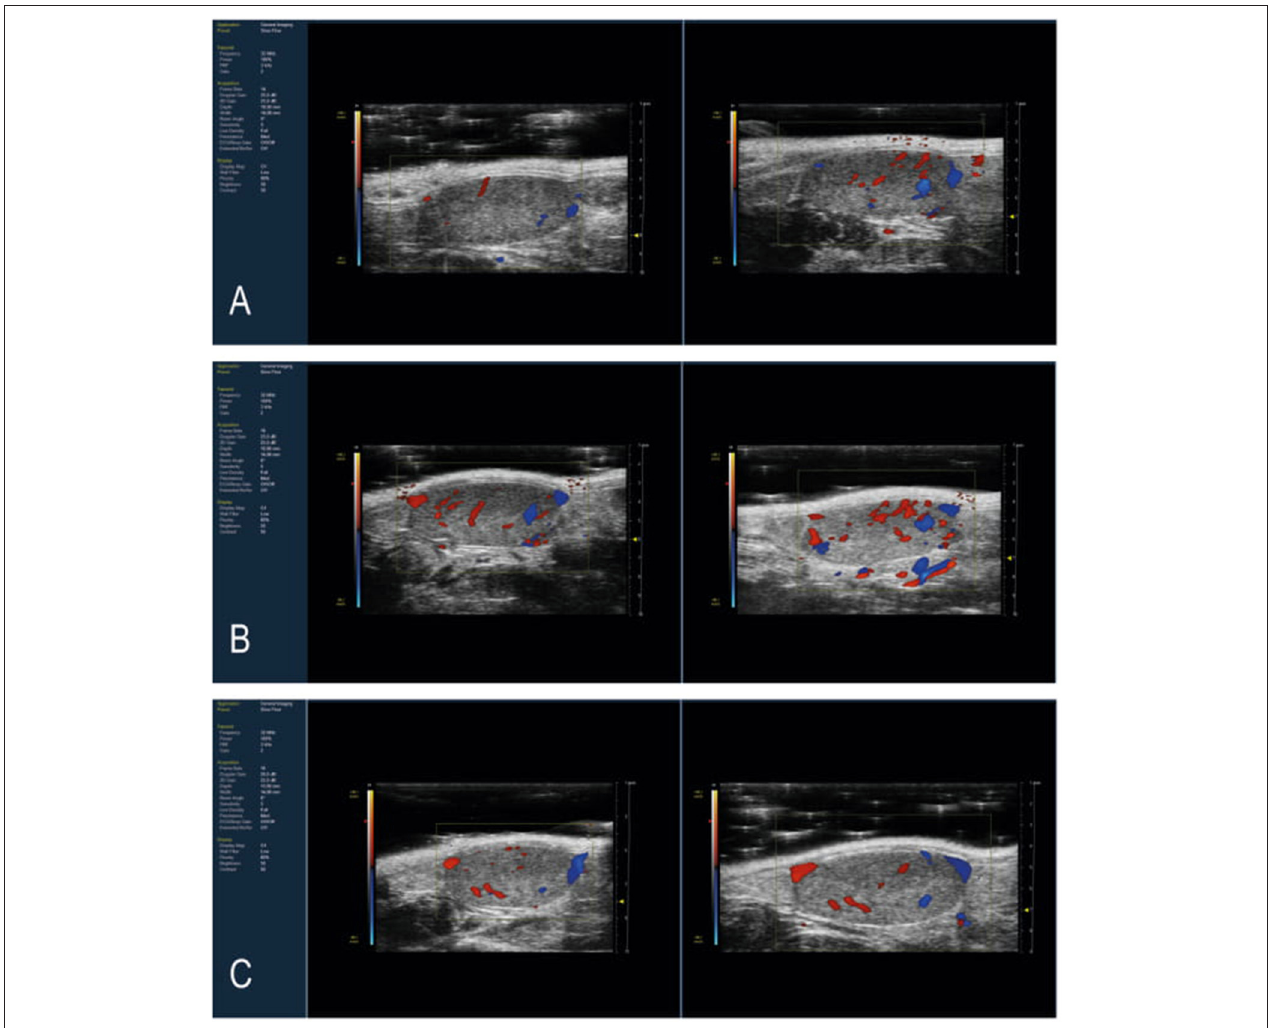
FIGURE 1 | Representative Longitudinal Scan of mouse testis with color Doppler HFUS image. Images of pre-treatment and post-treatment mice testis with (A) 10 mg/kg THC, (B) 50 mg/Kg maca, and (C) 10 mg/kg 1 9 -THC and 50 mg/Kg maca. After 30 days of treatment, the THC group showed more intense vascularization than the baseline. In contrast, the Maca and Maca + THC groups showed less differences in pre- and post-treatment